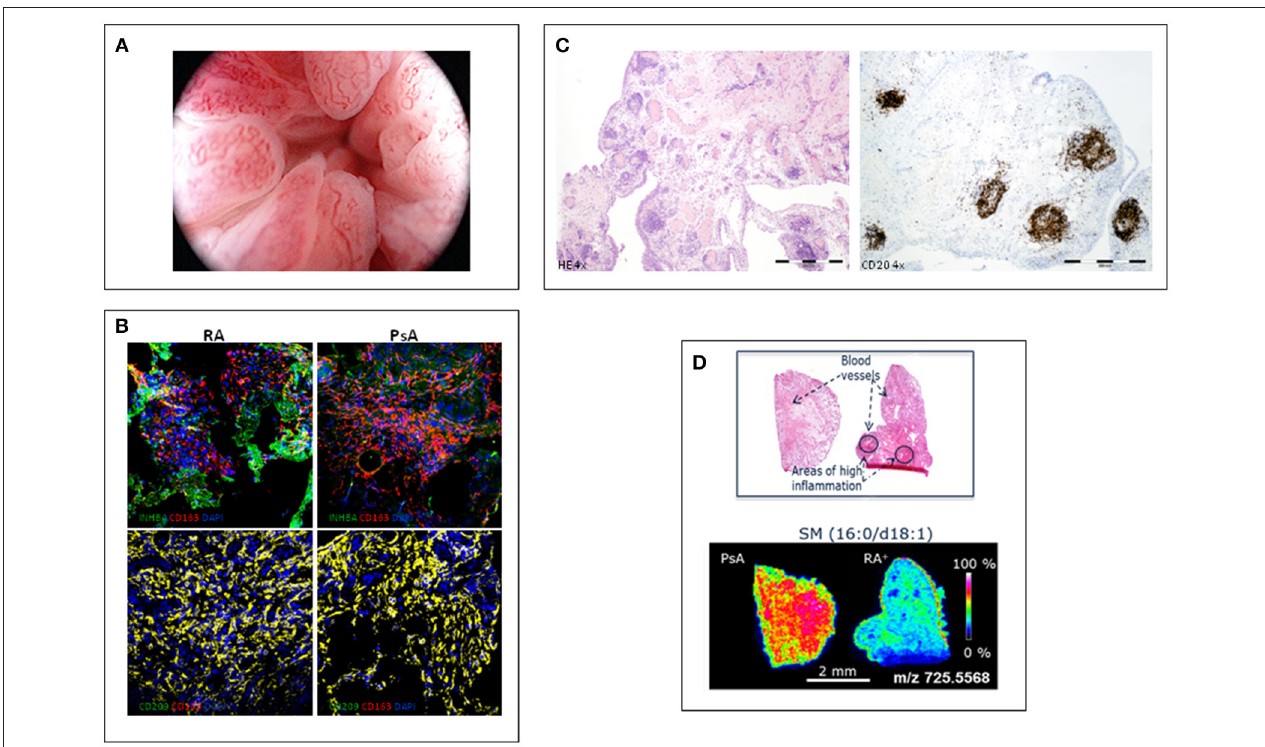
FIGURE 1 | Different features of psoriatic synovitis are represented. (A) Arthroscopic view of psoriatic synovitis with erithematous villae plenty of dilated, tortuous vessels. (B) Immunofluoresence analysis of the expression of macrophage-polarization markers in synovial tissue CD163 + macrophages from RA and PsA patients, as determined by confocal microscopy using anti-INHBA (Activin A) –a GM-CSF induced gene- and CD209 –a M-CSF induced gene- specific antibodies; nuclei were counterstained with DAPI (Courtesy of A Puig-Kröger, PhD, Madrid, Spain). (C) Staining of inflammed synovium from a patient with PsA; left: H-E staining (4x) showing a general view of synovial membrane standing out abundant vessels surrounded by folicular aggregates; right: CD20 staining (4x) highlighting the B-cell folicles in PsA synovitis. (D) Mass Spectometry Image analysis showing spatial mapping positive-lipid ion in synovium sections of PsA and RA. Scale bar shows normalized intensities (Courtesy of Prof. F Blanco, A Coruña,